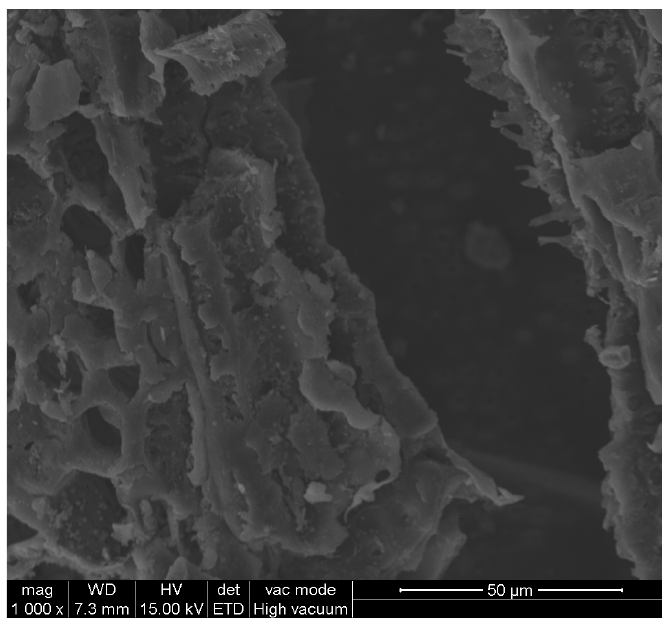
Figure 9. Bleached Ayous.